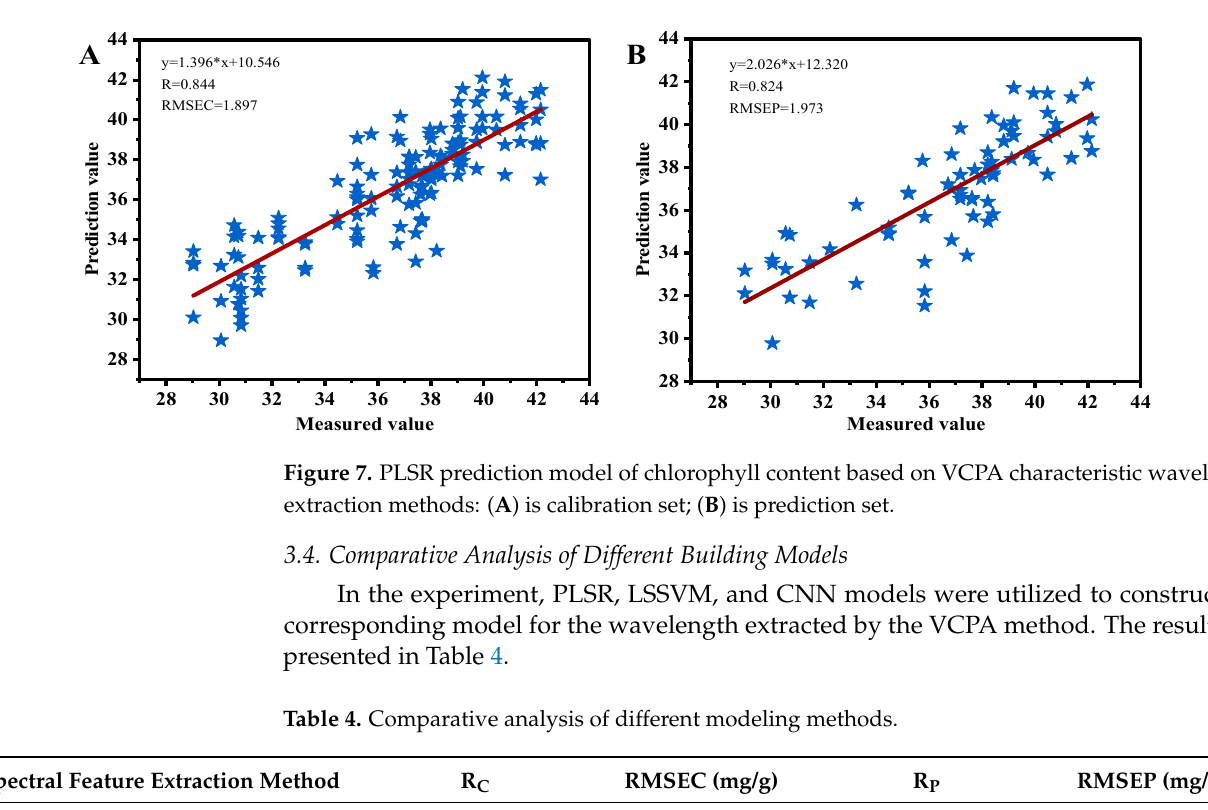
11 of 16 Figure 6. The running process of the selection of feature wavelengths: ( A ) is SPA; ( B ) is CARS; ( C ) is iVISSA; ( D ) is GAPLS; ( E ) is VCPA; ( F ) is UVE. 3.3.2. PLSR model of Characteristic Wavelengths Table 3 shows the application of the PLSR method to build a correlation model for the characteristic wavelengths screened by different methods, and the results of the anal- ysis are shown in Table 3. Table 3. PLSR models at different characteristic wavelengths of chlorophyll content. Type